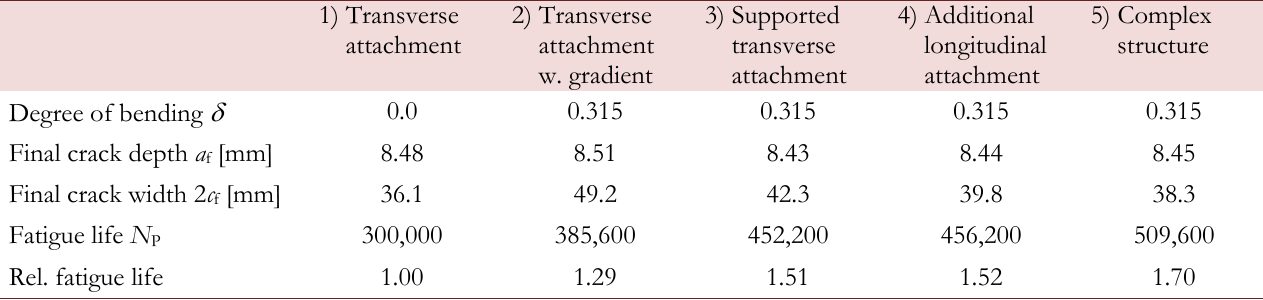
Table 1: Computed fatigue life N p for the same structural hot-spot stress  s = 176